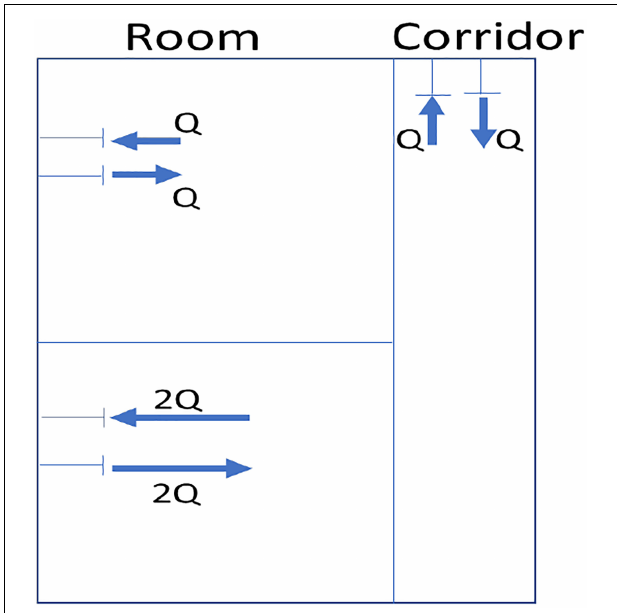
FIGURE 6 | Typical Norwegian design of office buildings; ( → ) and (Q) denote airflow.